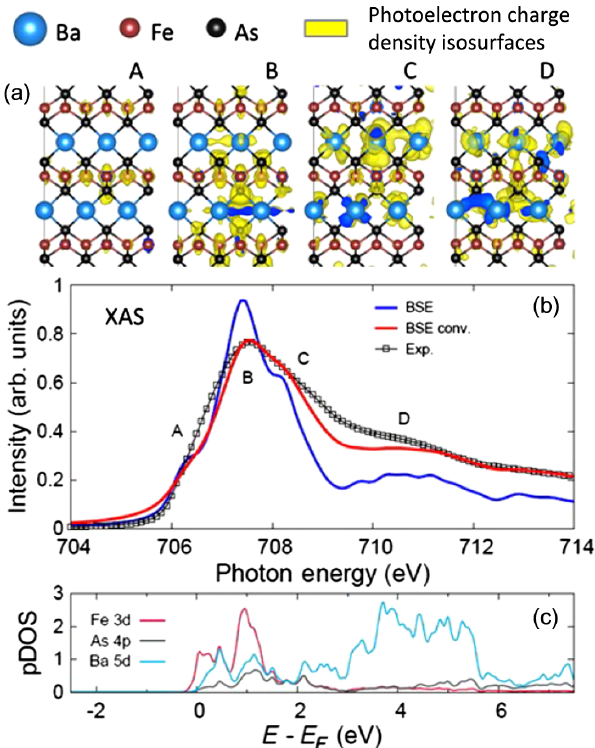
FIG. 1. X-ray absorption of BaFe 2 As 2 at the Fe L 3 edge. (a) Photoelectron charge density isosurfaces (yellow surfaces) for the BSE-calculated excitonic states A – D indicated in the XAS spectrum; the core-hole component of the exciton wave function is fixed at a central iron atom. (b) BSE calculation (blue curve) of the XAS compared with measurement (black symbols). The core- hole lifetime broadening is 0.2 eV half width at half maximum (HWHM). The red curve is obtained as described in the text by convolving the BSE spectrum with a Doniach-Sunjic spectral function of asymmetry parameter 0.14 and linewidth 0.16 eV that accounts for secondary electronic excitations. (c) Final-state local projected density of states (pDOS) of the unoccupied levels for selected